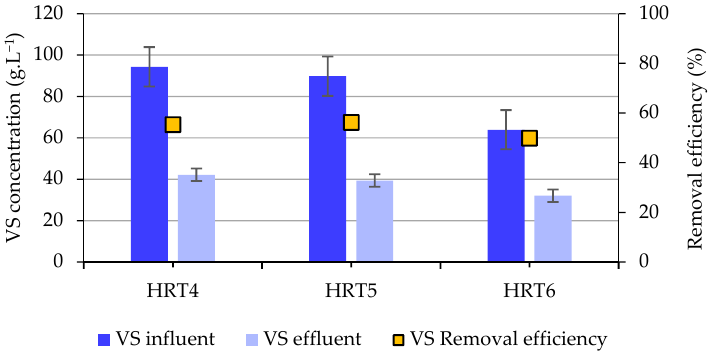
Figure 4. Average concentrations ( n = 3 samples per HRT) of total solids in the influent (TS influent) and effluent (TS effluent) of the bioreactor, and respective removal efficiencies (error bars: standard deviation) (concentrations: on the left y axis; removal efficiencies: on the right y axis).